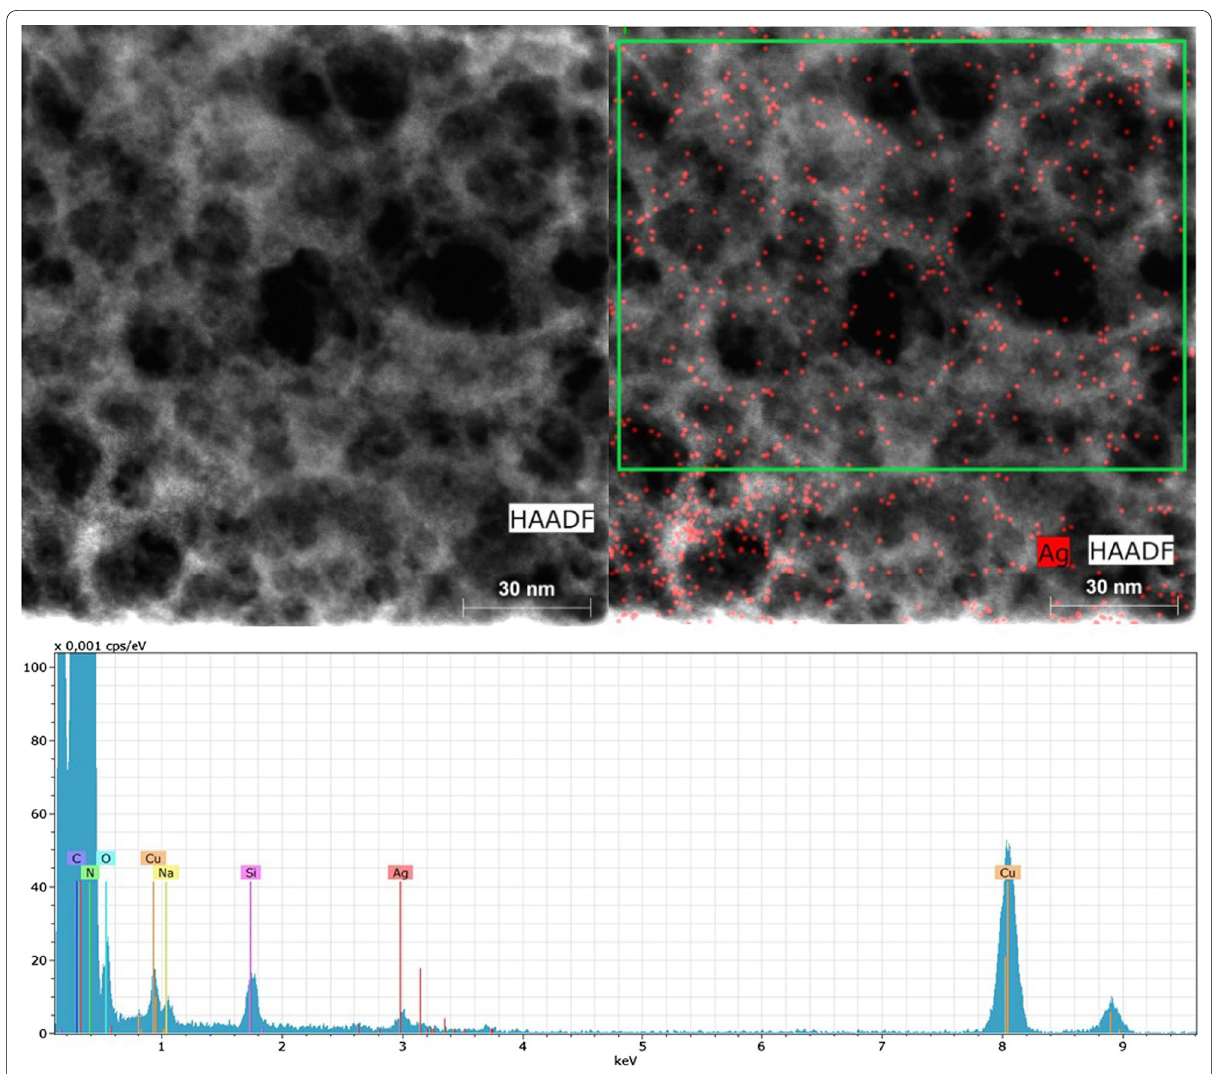
Fig. 3 HAADF-STEM micrographs and EDS spectrum (down) of